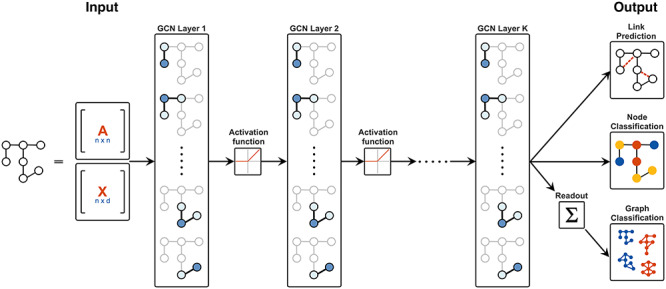
A visual depiction of a \documentclass[12pt]{minimal}
\usepackage{amsmath}
\usepackage{wasysym}
\usepackage{amsfonts}
\usepackage{amssymb}
\usepackage{amsbsy}
\usepackage{upgreek}
\usepackage{mathrsfs}
\setlength{\oddsidemargin}{-69pt}
\begin{document}
}{}$k$\end{document}-layer GCN. The input is the adjacency matrix \documentclass[12pt]{minimal}
\usepackage{amsmath}
\usepackage{wasysym}
\usepackage{amsfonts}
\usepackage{amssymb}
\usepackage{amsbsy}
\usepackage{upgreek}
\usepackage{mathrsfs}
\setlength{\oddsidemargin}{-69pt}
\begin{document}
}{}$\textbf{A} \in \mathbb{R}^{n \times n}$\end{document} of a graph and node attribute matrix \documentclass[12pt]{minimal}
\usepackage{amsmath}
\usepackage{wasysym}
\usepackage{amsfonts}
\usepackage{amssymb}
\usepackage{amsbsy}
\usepackage{upgreek}
\usepackage{mathrsfs}
\setlength{\oddsidemargin}{-69pt}
\begin{document}
}{}$\textbf{X} \in \mathbb{R}^{n \times d}$\end{document}. Each layer of the GCN aggregates over the neighborhood of each node, using the node representations from the previous layer in the network. The aggregations in each layer then pass through an activation function (here, \documentclass[12pt]{minimal}
\usepackage{amsmath}
\usepackage{wasysym}
\usepackage{amsfonts}
\usepackage{amssymb}
\usepackage{amsbsy}
\usepackage{upgreek}
\usepackage{mathrsfs}
\setlength{\oddsidemargin}{-69pt}
\begin{document}
}{}$ReLU$\end{document}) before going to the next layer. This network can be used to produce various different outputs: for predicting new edges in the input network (link prediction), classifying individual nodes in the input graph (node classification), or classifying the entire input graph (graph classification). In order to perform graph classification, an additional readout step (here, the sum over all nodes) is required to map the output from \documentclass[12pt]{minimal}
\usepackage{amsmath}
\usepackage{wasysym}
\usepackage{amsfonts}
\usepackage{amssymb}
\usepackage{amsbsy}
\usepackage{upgreek}
\usepackage{mathrsfs}
\setlength{\oddsidemargin}{-69pt}
\begin{document}
}{}$\mathbb{R}^{n \times c}$\end{document} to \documentclass[12pt]{minimal}
\usepackage{amsmath}
\usepackage{wasysym}
\usepackage{amsfonts}
\usepackage{amssymb}
\usepackage{amsbsy}
\usepackage{upgreek}
\usepackage{mathrsfs}
\setlength{\oddsidemargin}{-69pt}
\begin{document}
}{}$\mathbb{R}^{c}$\end{document}. The color represents the predicted classes for the respective entity in the output.